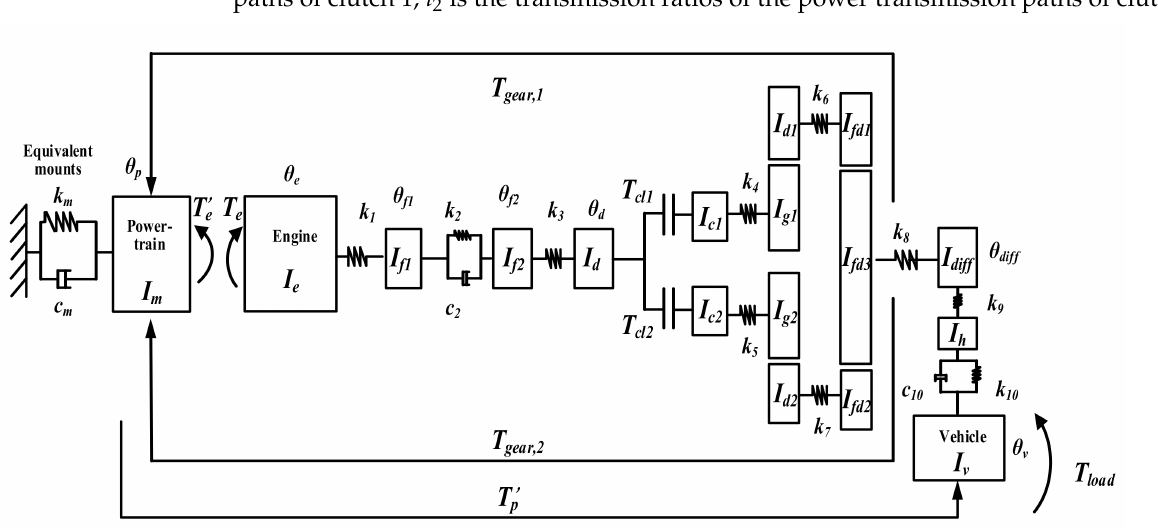
Figure 5. Dynamic model of a DCT